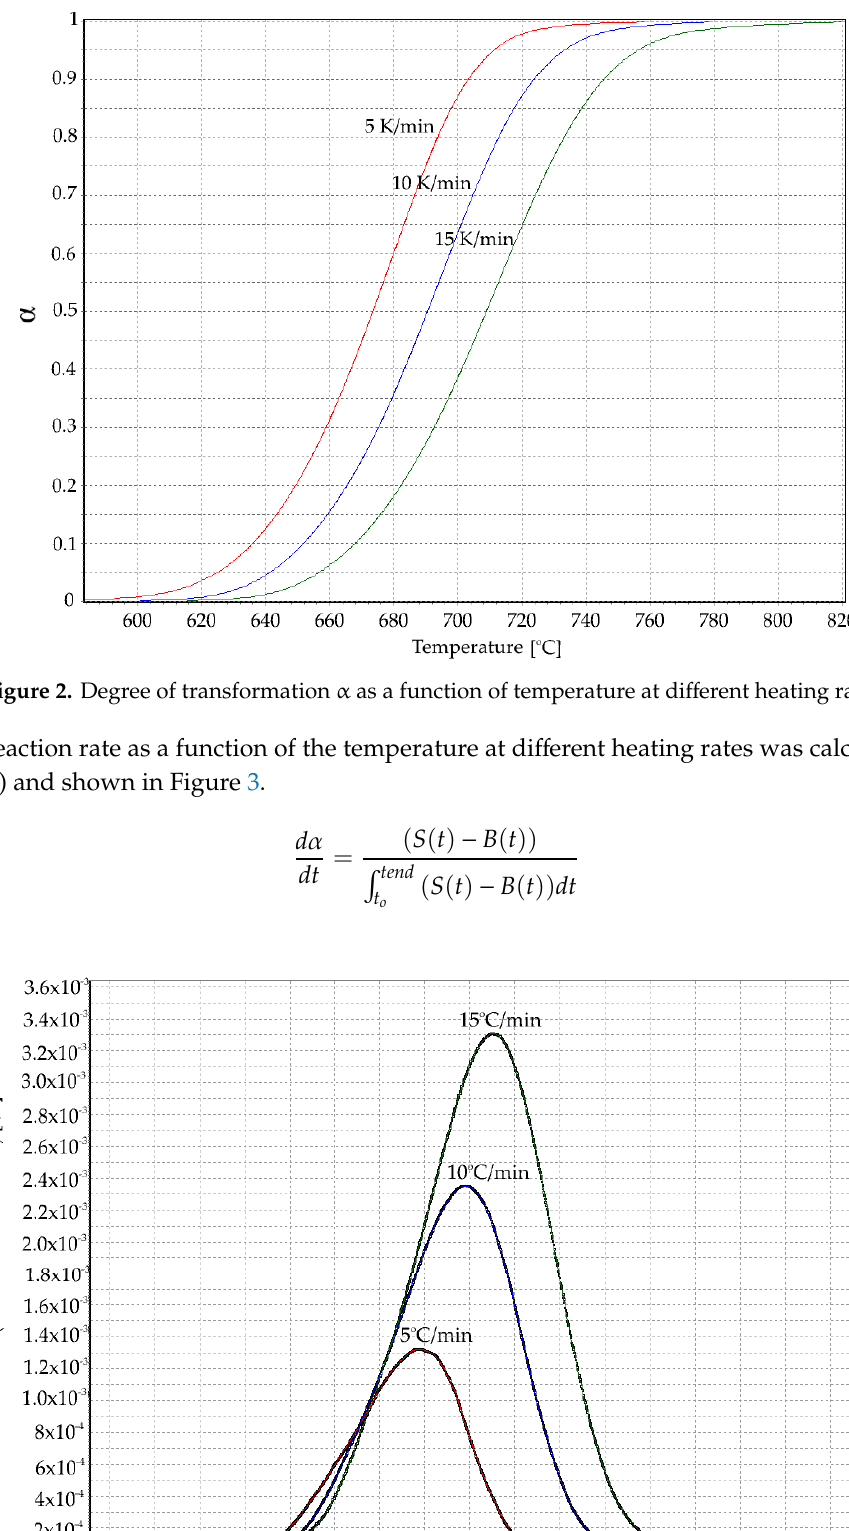
Figure 3. Conversion rates as a function of the temperature at heating rates β i = 5, 10, and 15°C/min.